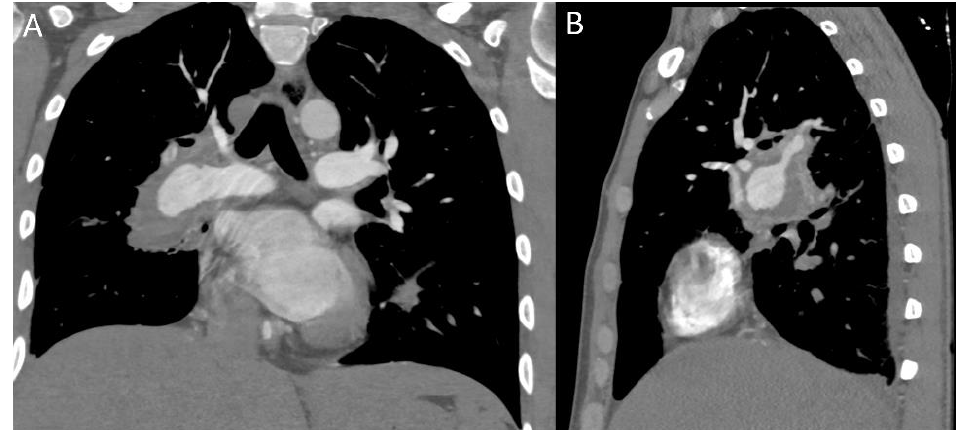
Figure 4. ( A , B ) Aneurysm of the middle lobar branch of the right pulmonary artery. MPR CT reconstructions in coronal and sagittal scans.